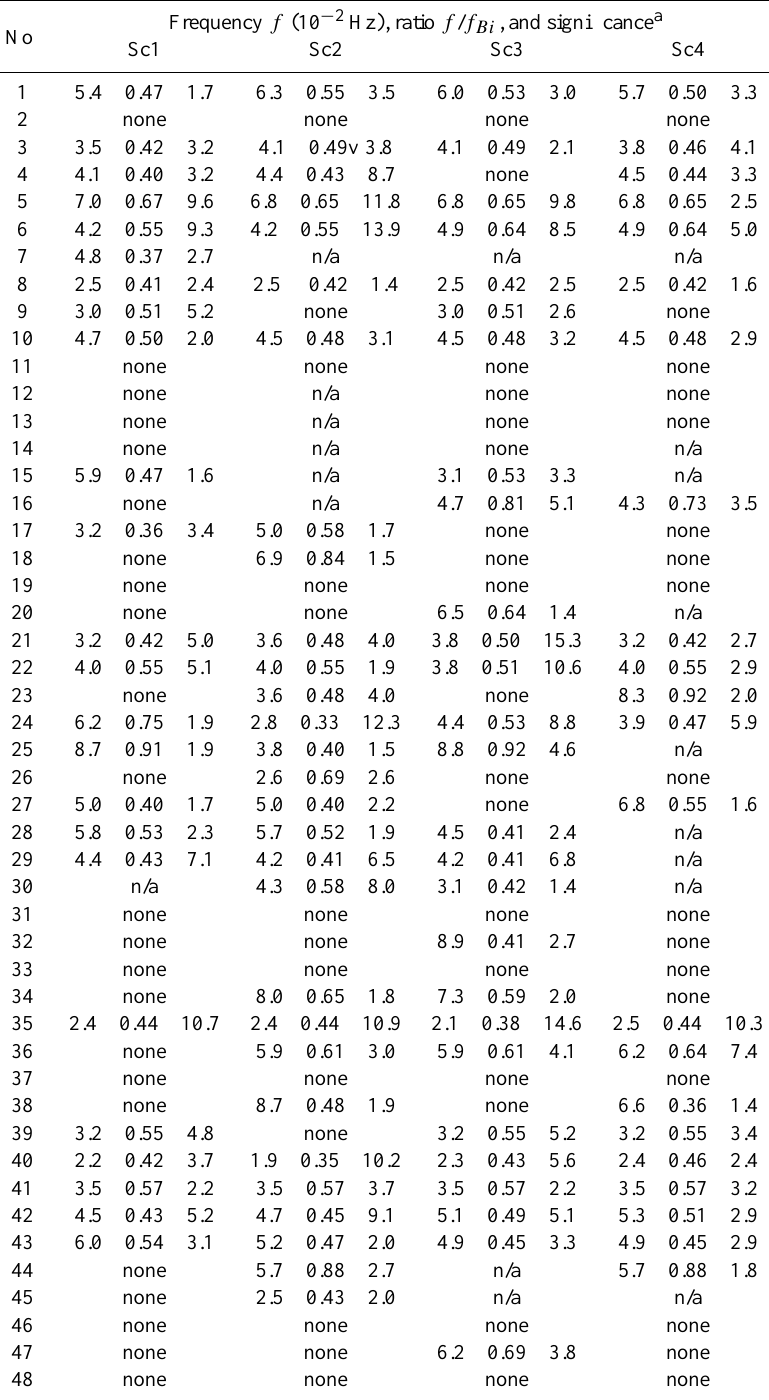
Table 3. Periodicities found in the wave